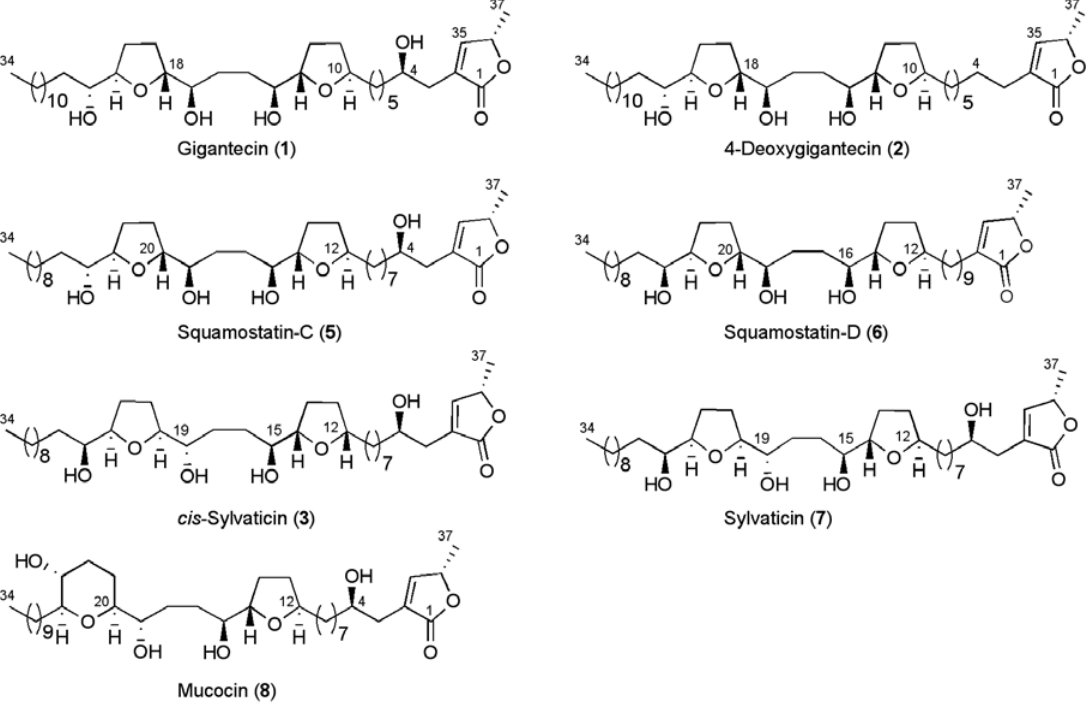
Figure 5. Structures of non-adjacent bis-THF and non-adjacent THF-THP acetogenins.